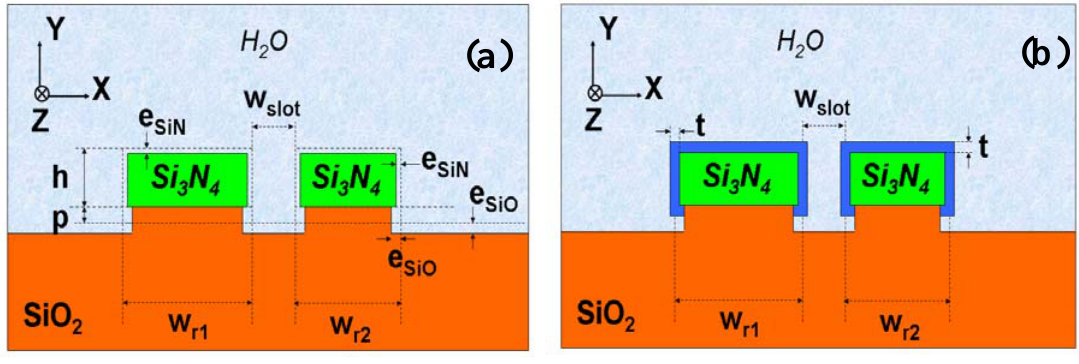
and (b) adlayer surface sensing [18]. w dimensions (before HF etching). e respectively, and t is the adlayer thickness.